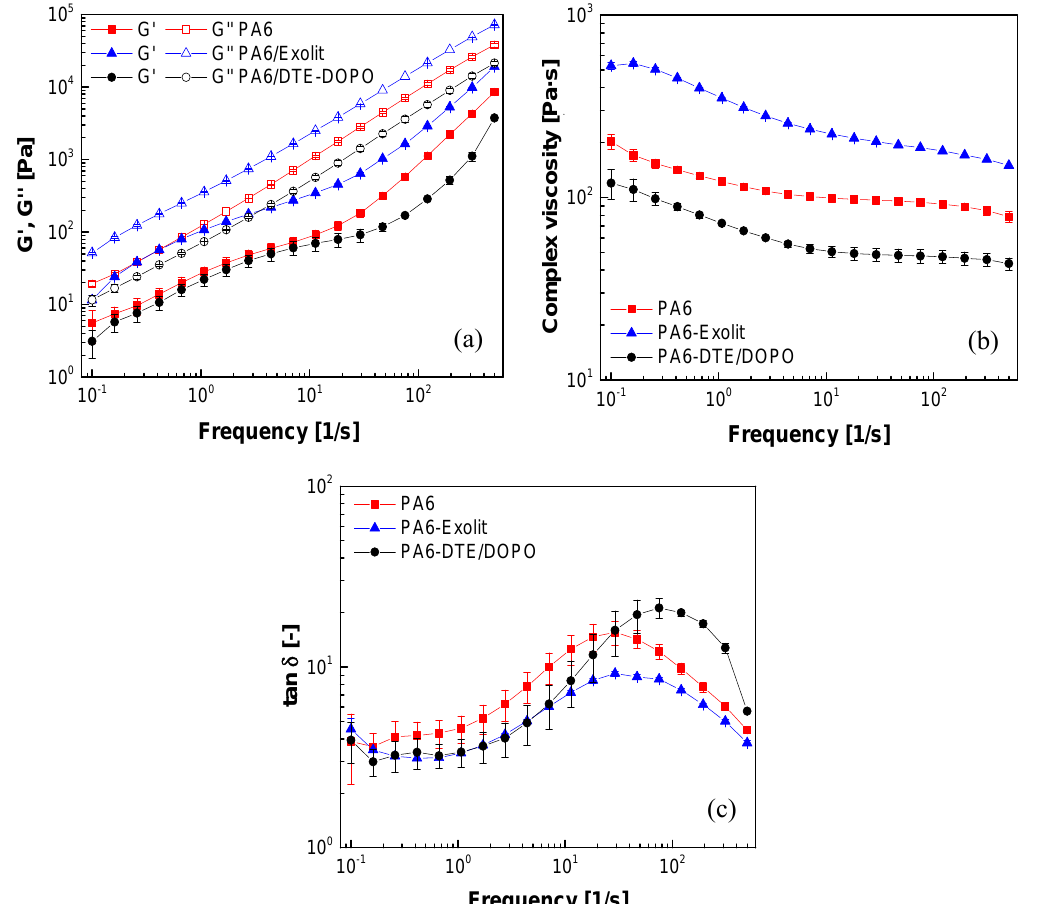
Figure 1. Evolution of ( a ) loss and storage modulus; ( b ) complex viscosity; and ( c ) loss factor (tan δ ) as a function of frequency for PA6 formulations at T = 250 °C and 1% strain.